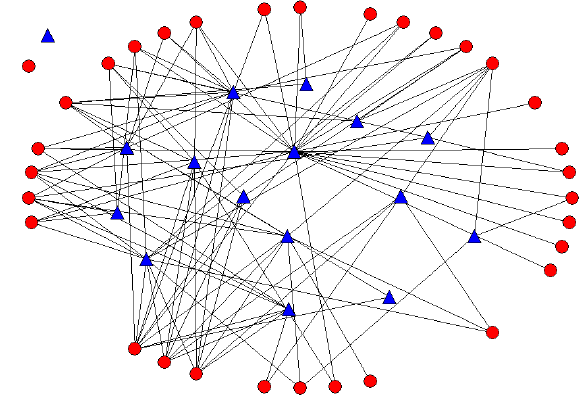
Figure 4: Network of interactions institutions-firms In the communicative network (Figure 5) we have a smaller number of directional relations: 101 as opposed to 106 resulting in a graph which is slightly more disconnected than the one that shows four isolated actors (three firms and one institution) and a lower inclusiveness (92%).